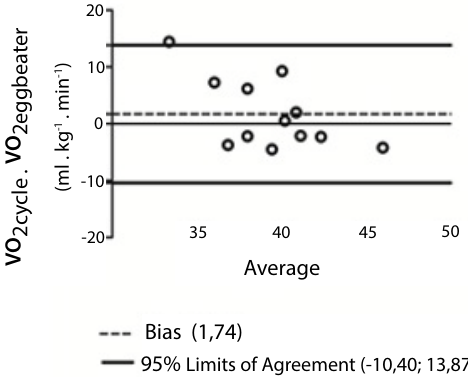
Figure 2. VO values’ Bland–Altmann analyses. 2